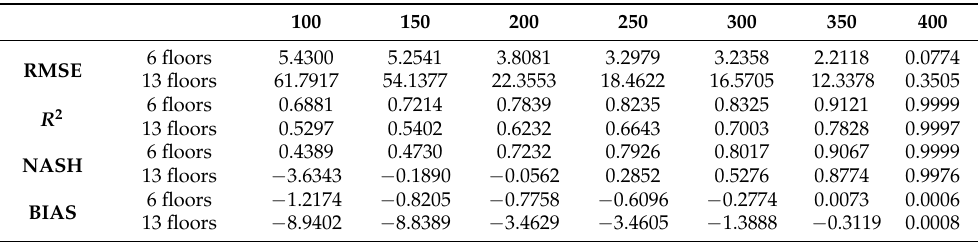
Figure 8. Results for the four statistical indices including RMSE (upper left), R 2 (upper right), NASH (lower left), and BIAS (lower right) for the maximum displacement estimation using six-floor and 13-floor buildings. Table 6. Statistical results for six parameters and various sampling sizes based on the six-floor and 13-floor buildings.